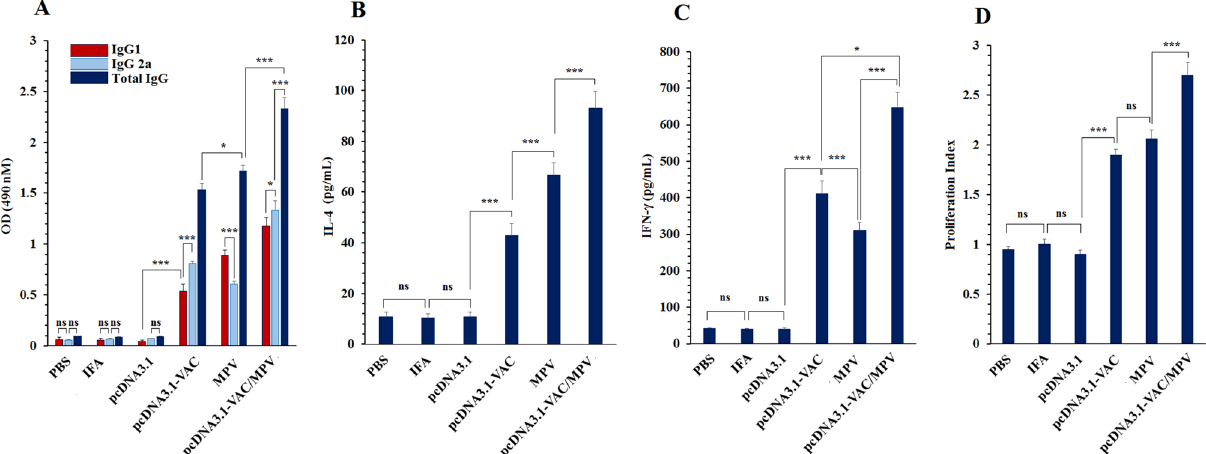
Figure 2. The immune response evaluation according to the serum level of antibody, cytokines secretion, and lymphocytes proliferation assay. ( A ) Serum level of the MPV-specific IgG total, IgG1, and IgG2a isotypes at different groups 2 weeks after the last injection (n = 5). ( B ) IL-4 secretion, ( C ) IFN-γ secretion, and ( D ) lymphoproliferative responses from the immunized mice splenocytes after in vitro restimulation with the MPV. 05 (*: 0.05 ≥ P > 0.01, **: 0.01 ≥ P > 0.001, ***: P < 0.001, ns: not